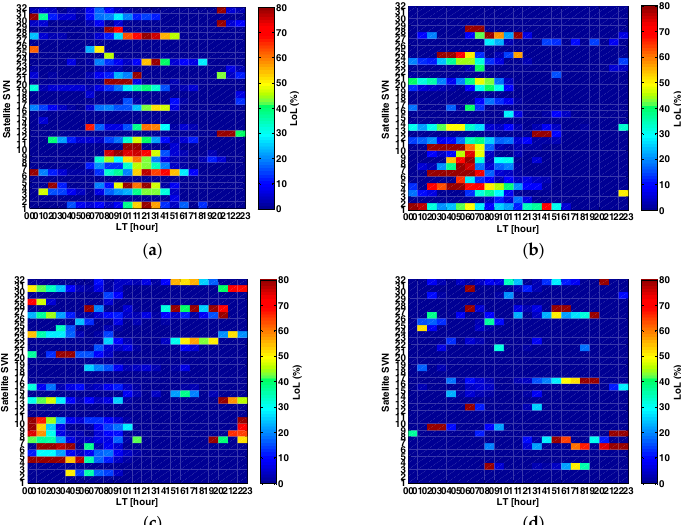
Figure 3. Seasonal statistics of loss of lock percentage by scintillation (from 2011 to 2015). ( a ) FMA; ( b ) MJJ; ( c ) ASO; and ( d ) NDJ. In general, the seasonal variation of loss of lock occurrence percentage under scintillation is positively correlated with asymmetry equatorial ionization anomaly (EIA) proxy [25], and it is consistent with previous studies of the summer solstice case.